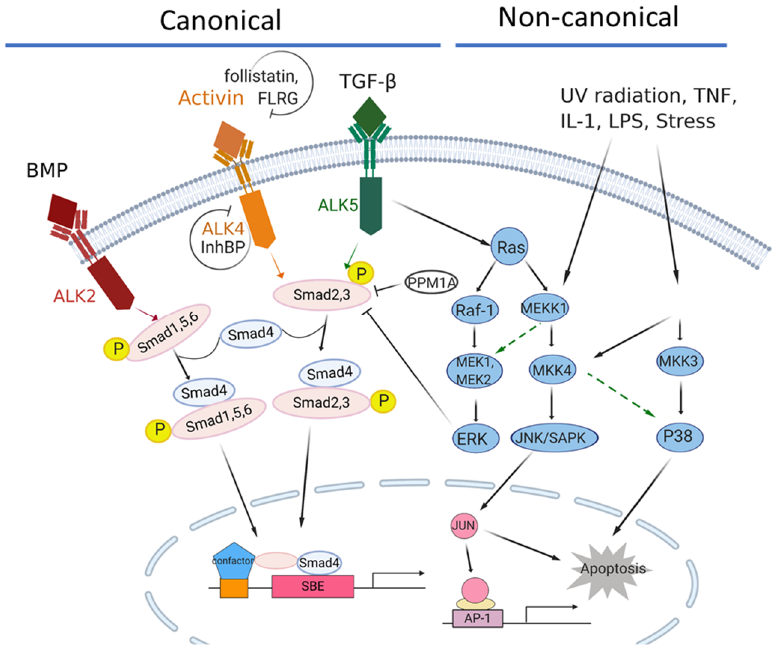
Figure 1. The activin/TGFβ signaling network in pancreatic cancer. The canonical signaling axis of the TGF-β superfamily members is Smad4-dependent, while the non-canonical signaling is Smad4-independent. ACVR1B/ALK4 is the major type I receptor for the activin signaling pathway, while TGFRB1/ALK5 and ACVR1/ALK2 are the major type I receptors for TGFβ and BMP signaling, respectively. In the canonical activin signaling, the pathway is activated by the binding of activins to one of the two type II receptors, ACVR2A or ACVR2B, which then recruit a type 1 receptor, such as ACVR1B/ALK4. The activated ACVR1B/ALK4 receptor subsequently recruits and phosphorylates SMAD2 and SMAD3, which then bind to the coregulatory SMAD4, and the complex translocates into the nucleus where it regulates gene transcriptions. Activin bioactivity can be modulated by antagonists, such as Follistatin, FLRG (follistatin-related gene), InhBP (inhibin-binding protein),